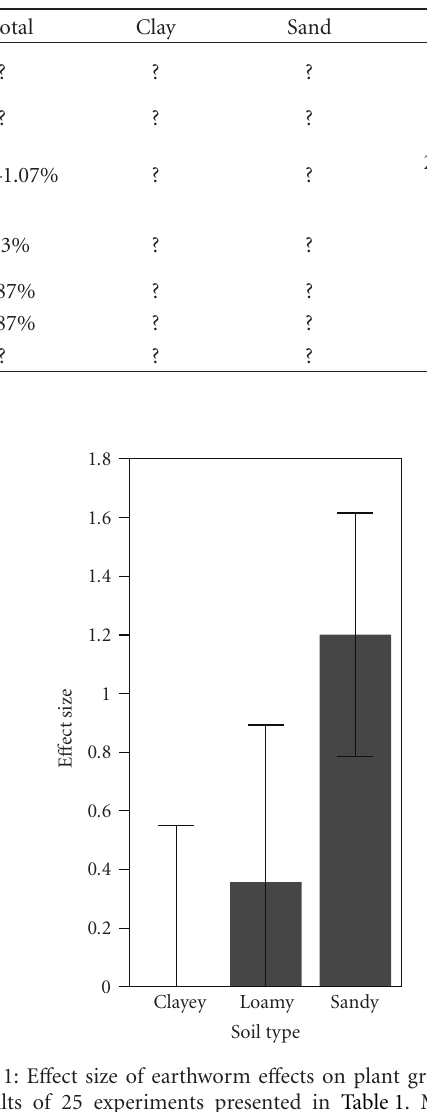
contrasting texture properties (sandy, clayey, or loamy soil). The e ff ect size was computed as ( M 1 − M 2)/ σ , with M 1: mean plant biomass in the presence of earthworms, M 2: mean plant biomass without earthworm, and σ : standard deviation without earthworm [32]. An ANOVA was then used to test for the e ff ect of soil texture on the e ff ect size, that is, on the magnitude of earthworm impact on plant biomass. This shows that soil texture influences significantly earthworm impact on plant growth ( r 2 = 0 . 11 and P = . 02). LS mean comparisons show that the e ff ect size was in sandy and loamy soils, respectively, 60- and 17.5- fold higher than in clayey soil. The result highlights a strong positive e ff ect size in sandy soil and a weakly negative e ff ect in clayey soil (Figure